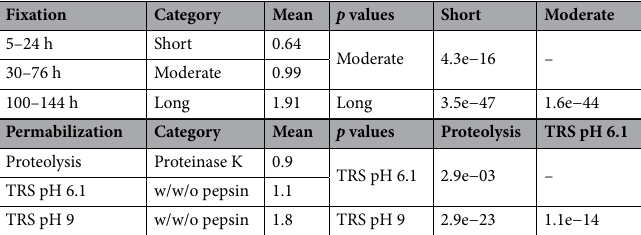
tissue samples after long-term storage.